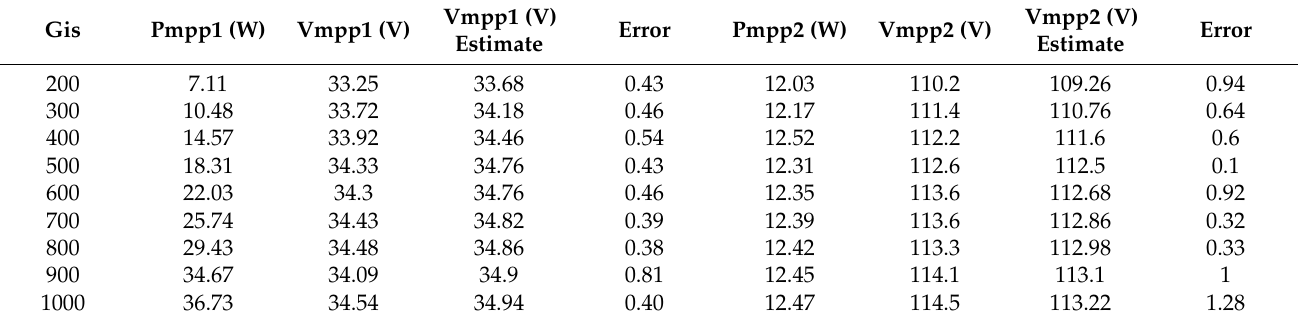
Table 6. The P-V characteristic data for test 4.